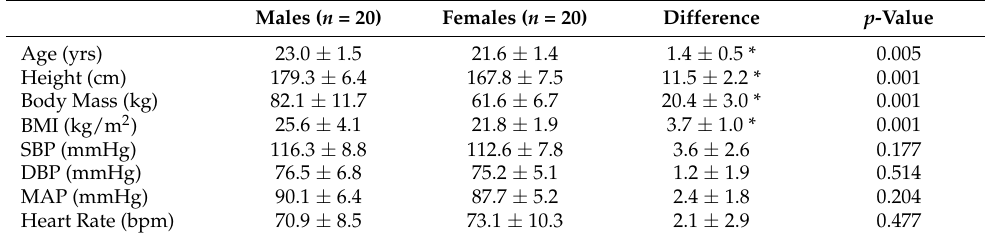
Table 1. Participant